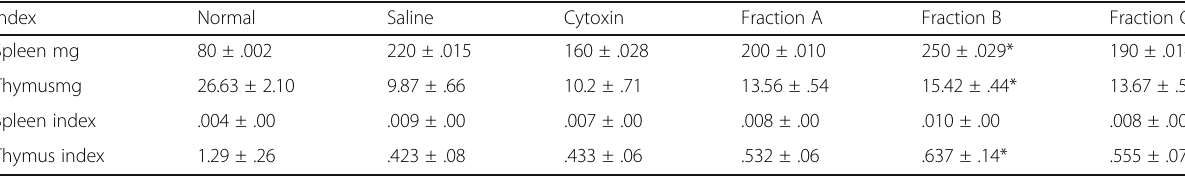
Table 2 Effect of Licorice polysaccharide on immune organs index